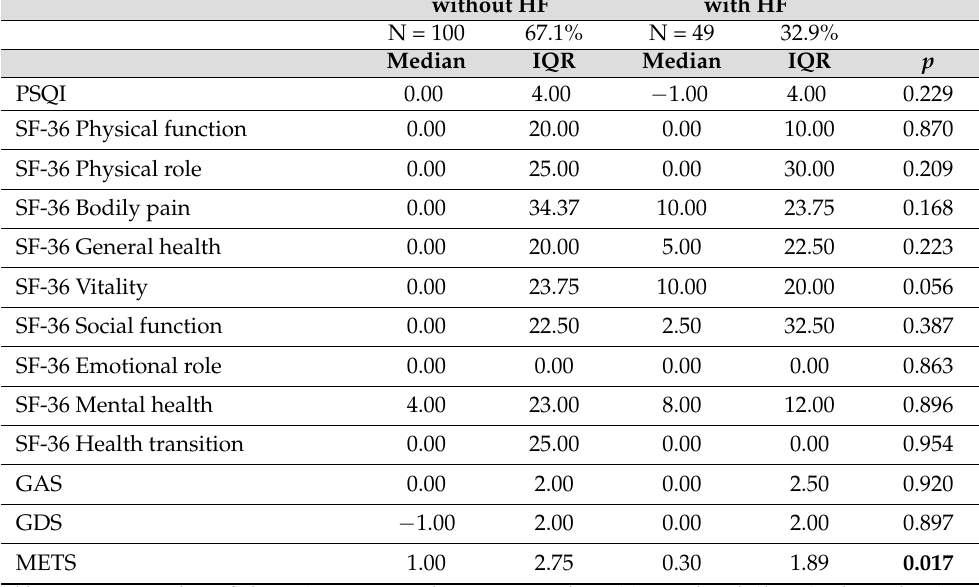
Table A1. Comparison of differences between baseline and final values based on heart failure including only the patients who have undergone thrice weekly sessions.